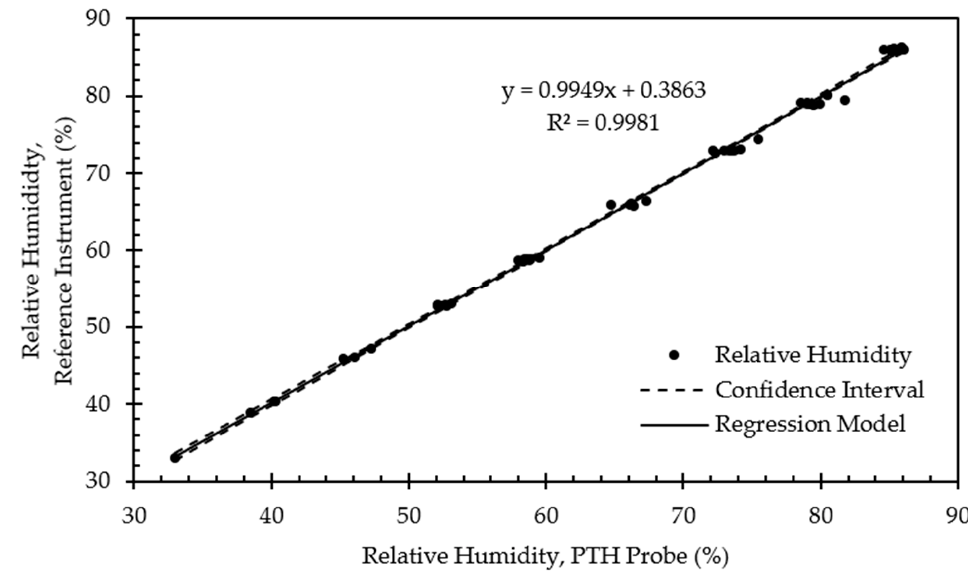
Figure 16. Regression model and corresponding confidence interval for relative humidity validation data from representative PTH probe (SN: 0x0005). Table 10. Regression model coefficients for calibrated PTH